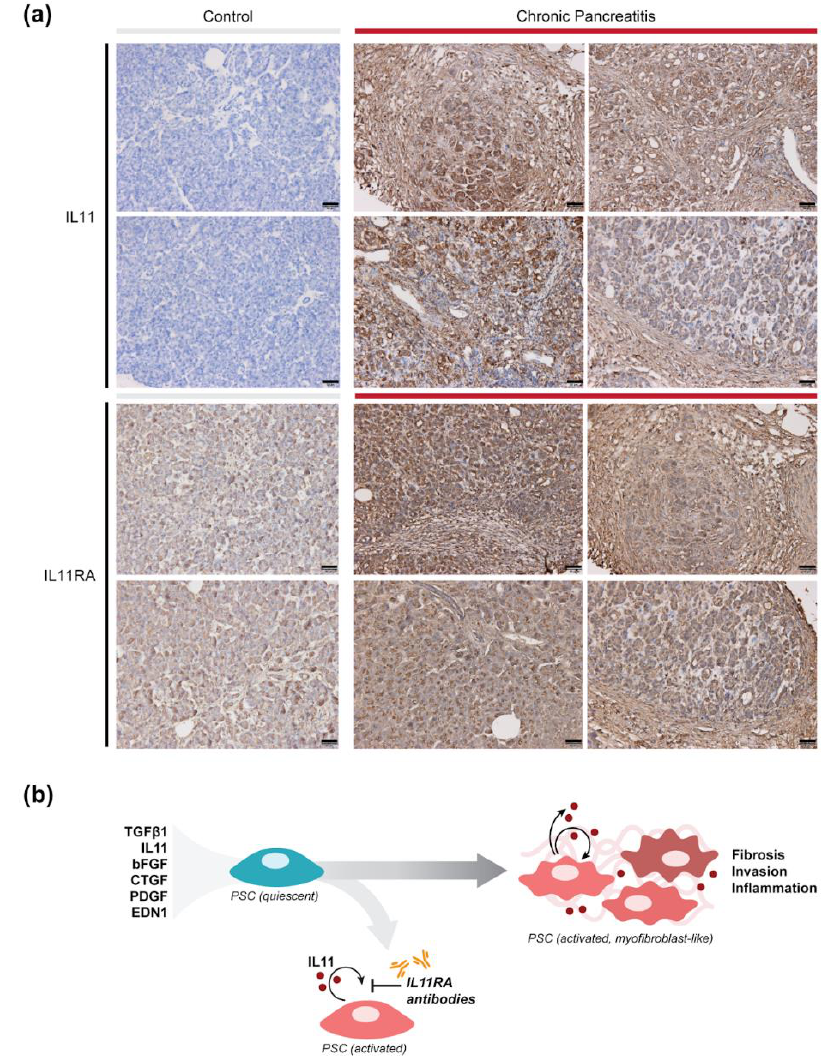
Figure 6. IL11 and IL11RA expression are elevated in human chronic pancreatitis. ( a ) Immunohisto- chemistry staining of IL11 and IL11RA in normal human (control) or chronic pancreatitis tissue. Scale bars: 50 µ m. ( b ) Schematic of the working model of IL11-mediated PSC activation in pancreatitis. Our data suggest that IL11 is induced downstream of multiple pancreatitis factors and acts in an autocrine manner to promote myofibroblast differentiation and its associated effector functions including extracellular matrix production, invasion and the secretion of pro-inflammatory cytokines. Blocking the IL11-autocrine loop using neutralizing IL11RA antibodies prevents myofibroblast differentiation and has protective effects against fibro-inflammation in the pancreas.